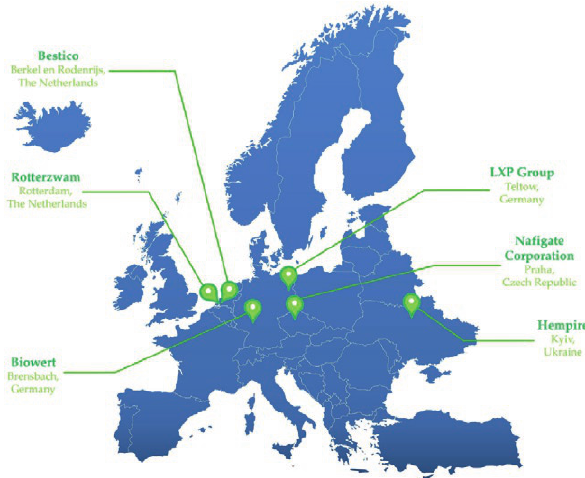
Figure 2. Locations of the companies operating the good practice cases listed in Table